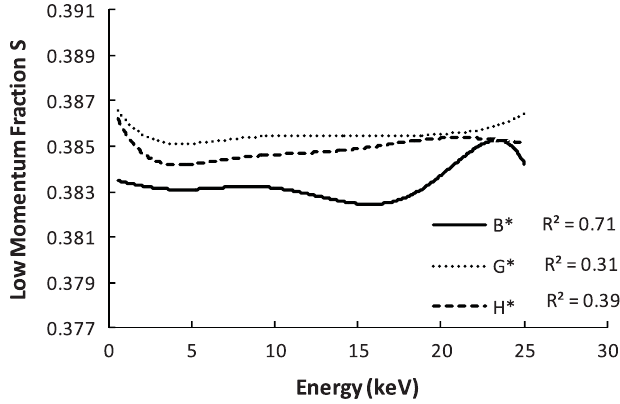
samples.FIG. 11. Low momentum annihilation fraction S vs positron energy for unbaked ( B (cid:7) ) and baked ( G (cid:7) , H (cid:7) ) FG samples.